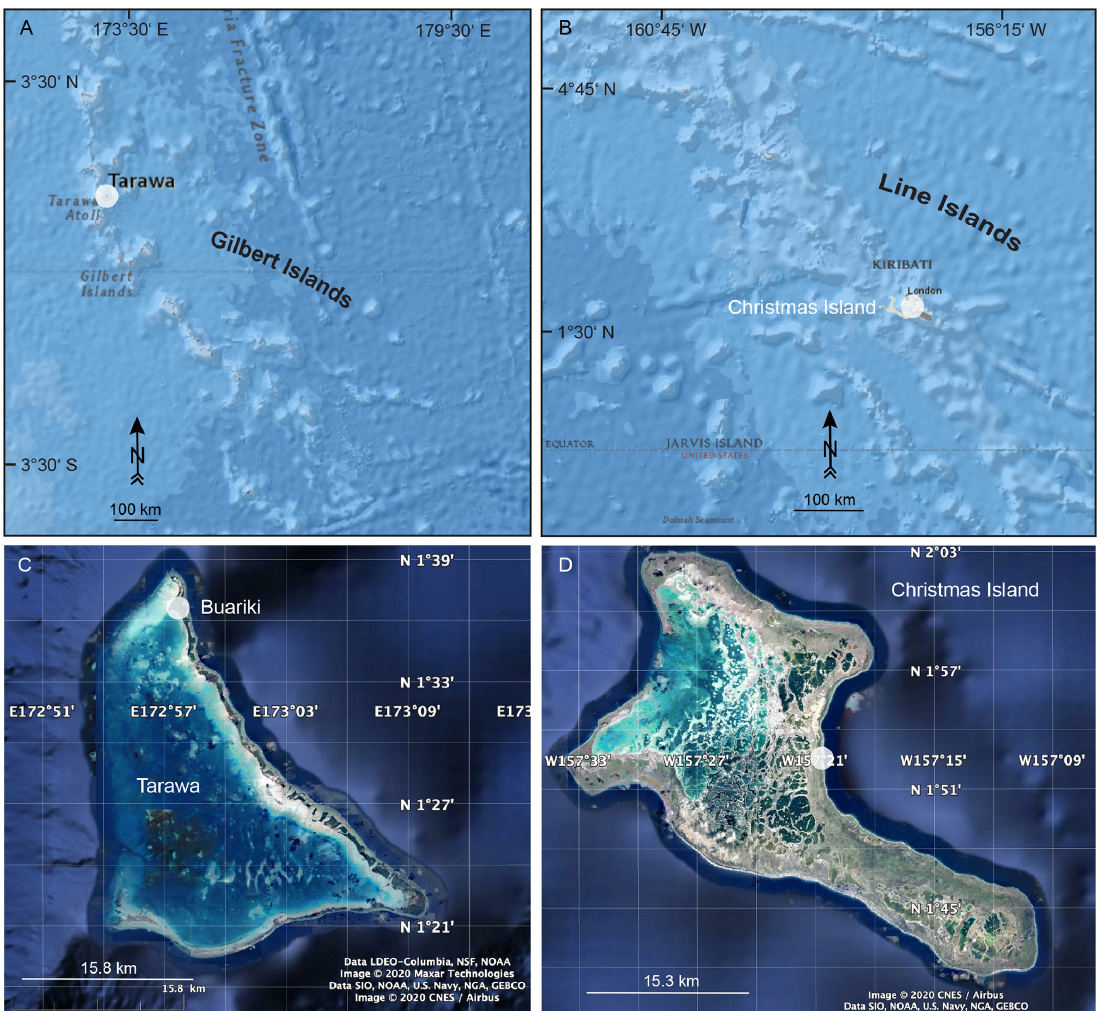
Figure 8. Map showing islands in Kiribati considered in this article (white circles). Study sites on Tarawa and Christmas Island are indicated by white circles. Basemap: “National Geographic Map”, with data from National Geographic, Esri, Garmin, HERE, UNEP-WCMC, USGS, NASA, ESA, METI, NRCAN, GEBCO, NOAA and INCREMENT P Corp (a–b) . © Google Earth 2020 (c–d)